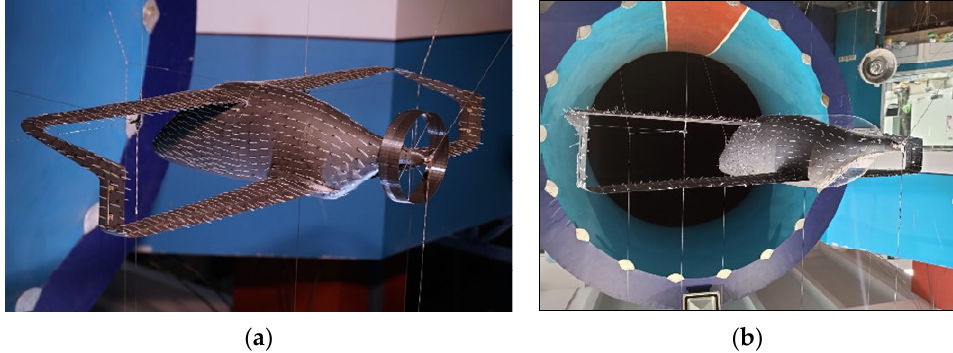
Figure 2. Models with tufts for flow visualization in T-1 wind tunnel 2.25 × 3 m test section ( a ) with an idle duct and ( b ) with vertical fishtail surfaces.